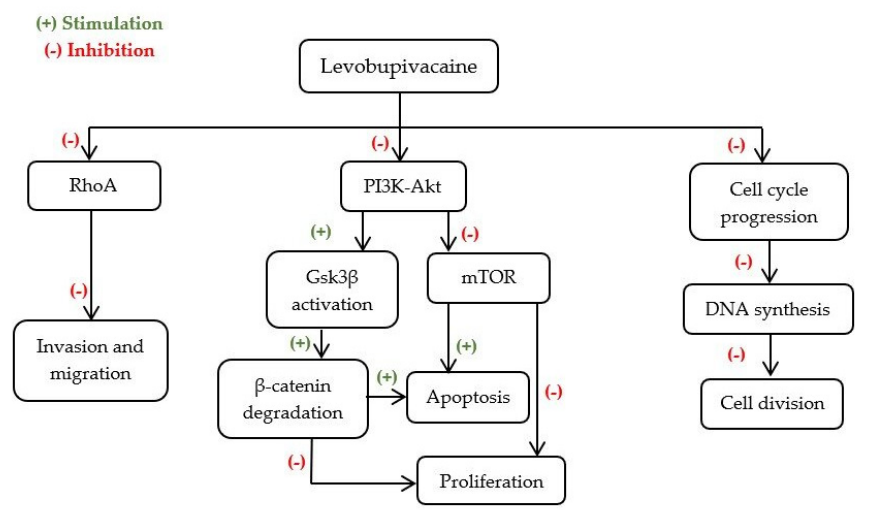
Figure 4. Possible mechanisms underlying levobupivacaine’s anti-cancer effects. DNA—Deoxyri- bonucleic acid; Gsk3 β —Glycogen synthase kinase 3 beta; mTOR—Mammalian target of rapamycin; PI3K-Akt—Phosphatidylinositol 3-kinase—Protein kinase B; RhoA—Ras homolog family member A.